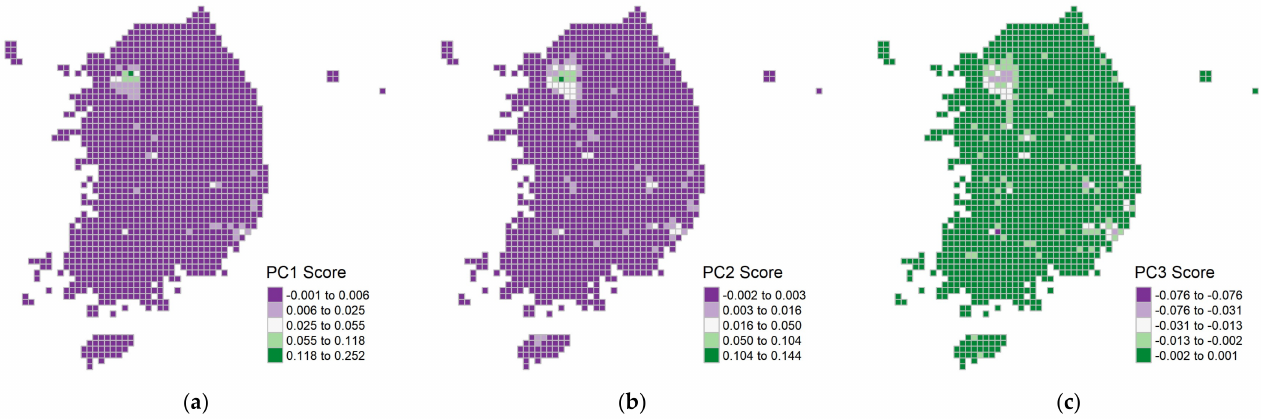
Figure 6. Spatial distribution of the PC scores from sparse PCA: ( a ) PC1 scores; ( b ) PC2 scores; ( c ) PC3